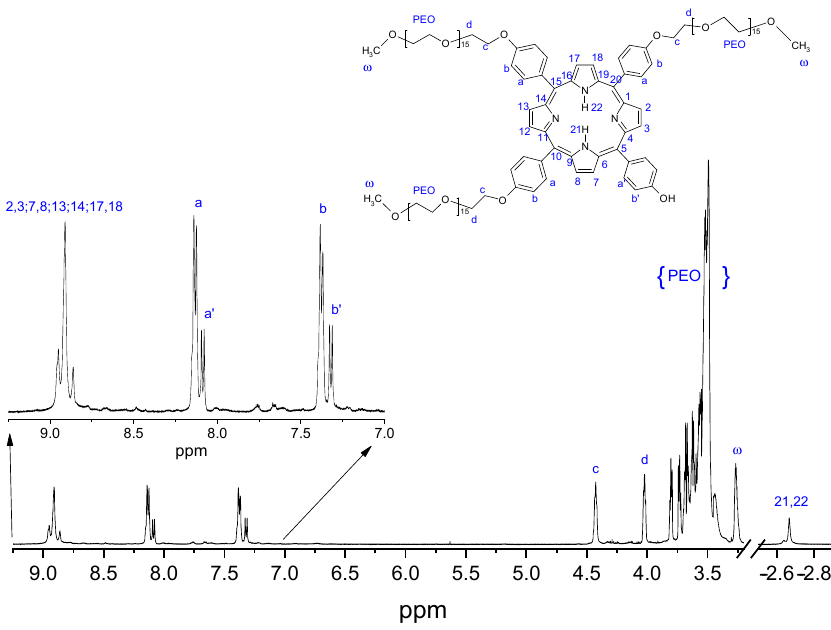
Figure 2. 1 H-NMR spectrum of P(PEG350) 3 , solvent Acetone-d6, 27 °C, 500 MHz.